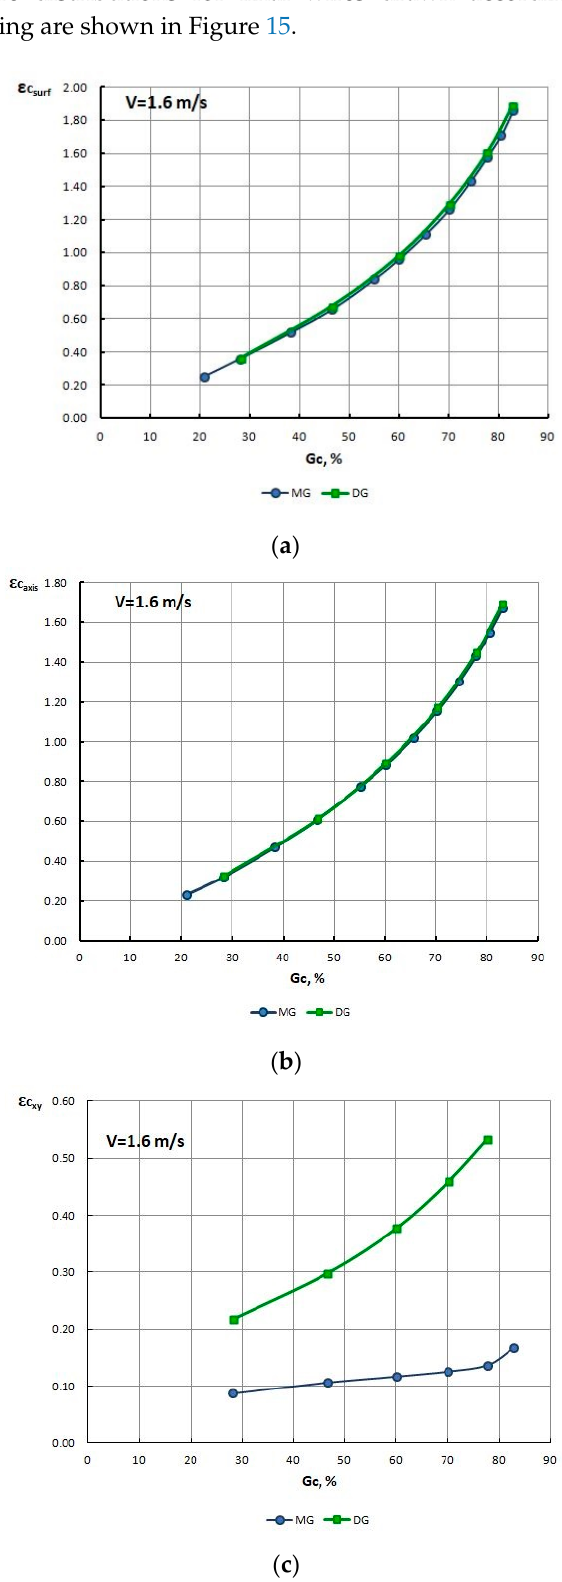
Figure 12. Change of strain level on the surface ( a ), axis ( b ) and non-dilatational strain ( c ) in wires drawn with low MG and high DG single section reductions, at a drawing speed of V c = 1.6 m / s, as a function of the total drawing reduction G c %.